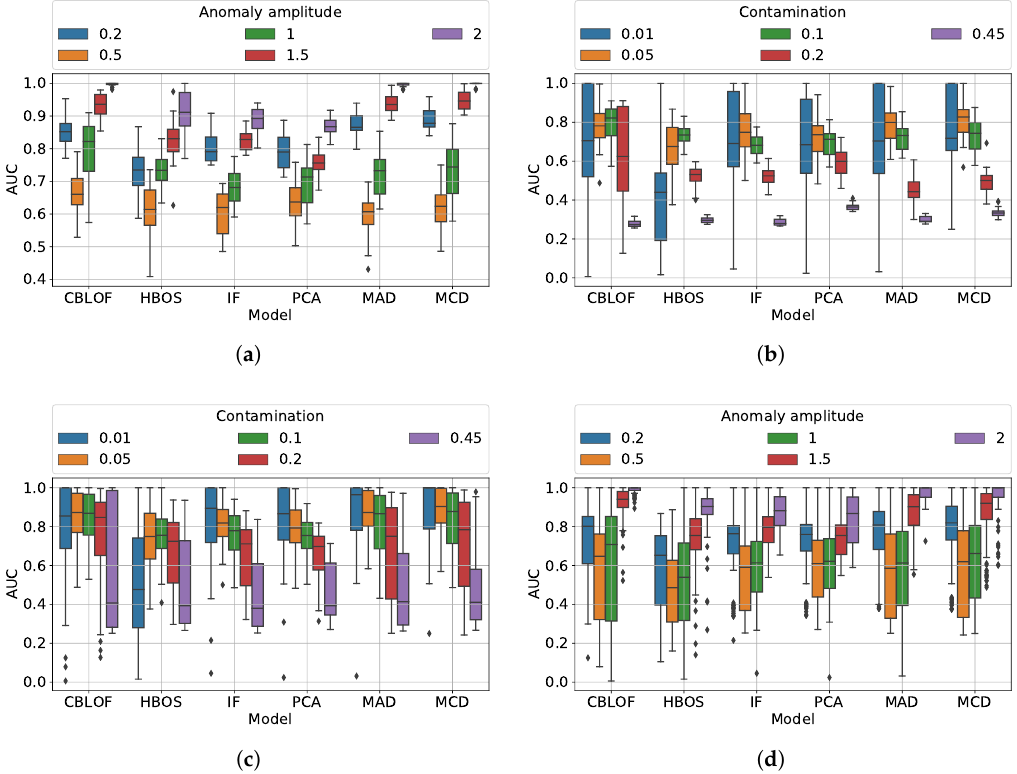
Figure 7. Complete failure. ( a ) Fixed contamination 10%. The anomaly amplitude varies. ( b ) Fixed anomaly amplitude 1. The contamination varies. ( c ) General case, where both the anomaly amplitude and the contamination vary. Contamination view. ( d ) General case, where both the anomaly amplitude and the contamination vary. Anomaly amplitude